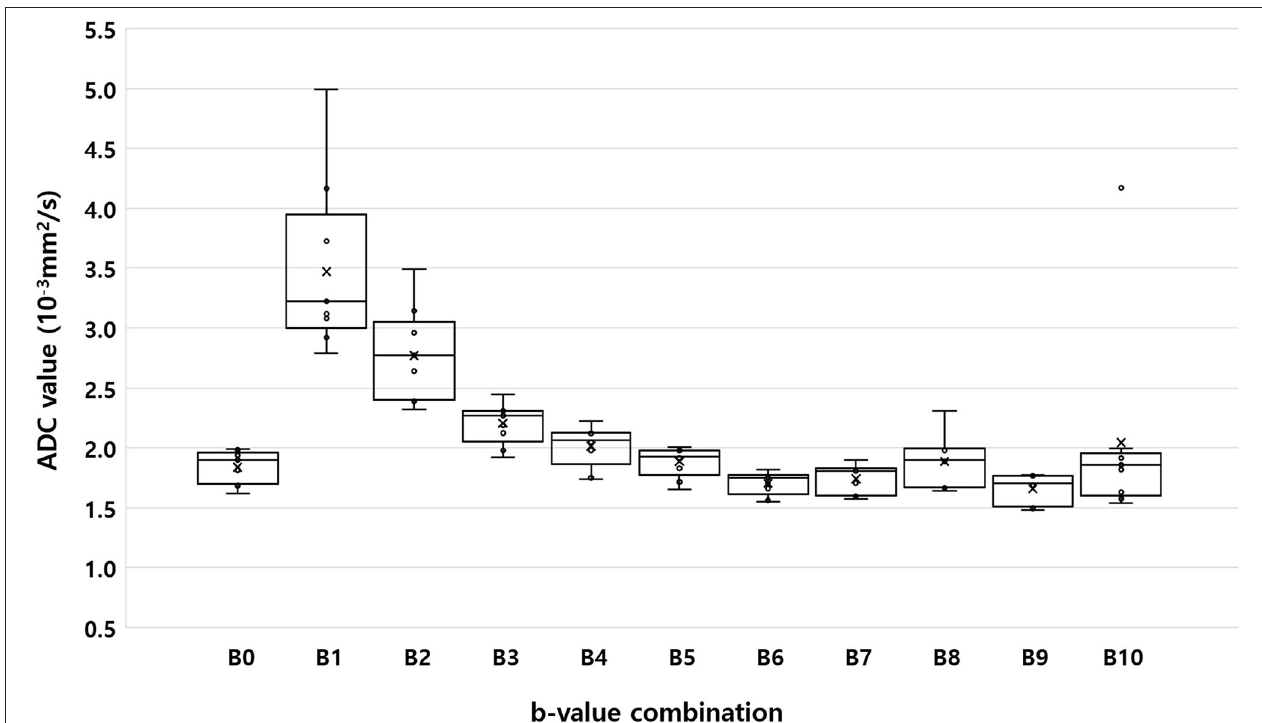
FIGURE 2 | Box-plot of median apparent diffusion coefficient calculated using the monoexponential model with nine b-values (B0; b = 0, 50, 70, 100, 150, 200, 500, 800, and 1,000 s/mm 2 ), and 10 different b-value combinations consisting of three b-values each (B1: b = 0, 50, and 100 s/mm 2 ; B2: b = 0, 100, and 200 s/mm 2 ; B3: b = 0, 200, and 500 s/mm 2 ; B4: b = 0, 200, and 800 s/mm 2 ; B5: b = 0, 500, and 1,000 s/mm 2 ; B6: b = 0, 800, and 1,000 s/mm 2 ; B7: b = 0, 50, and 800 s/mm 2 ; B8: b = 0, 100, and 800 s/mm 2 ; B9: b = 0, 50, and 1,000 s/mm 2 ; and B10: b = 0, 100, and 1,000 s/mm 2 ). Within each box, the horizontal line marks the median value. Boxes extend from the 25 th to the 75 th percentile of each value’s distribution. Vertical extending lines denote the minimum and maximum values.